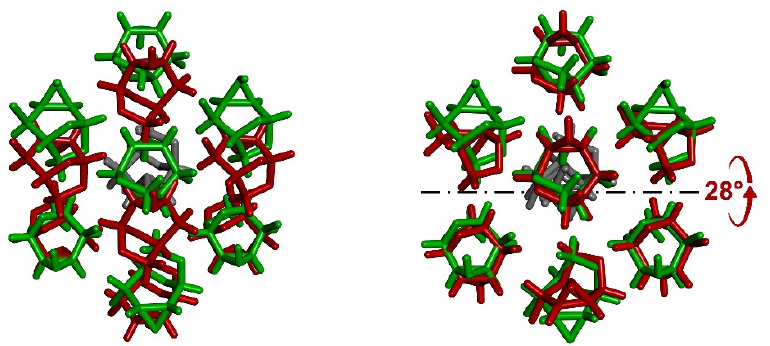
Figure 13. Front view (left) of overlaid structures II (green) and VII (red), molecules in the back (left) and in the front (right). Front view (right) of overlaid structures II (green) and VII (red) where VII is rotated approximately by 28°. Parent molecules are depicted in gray.